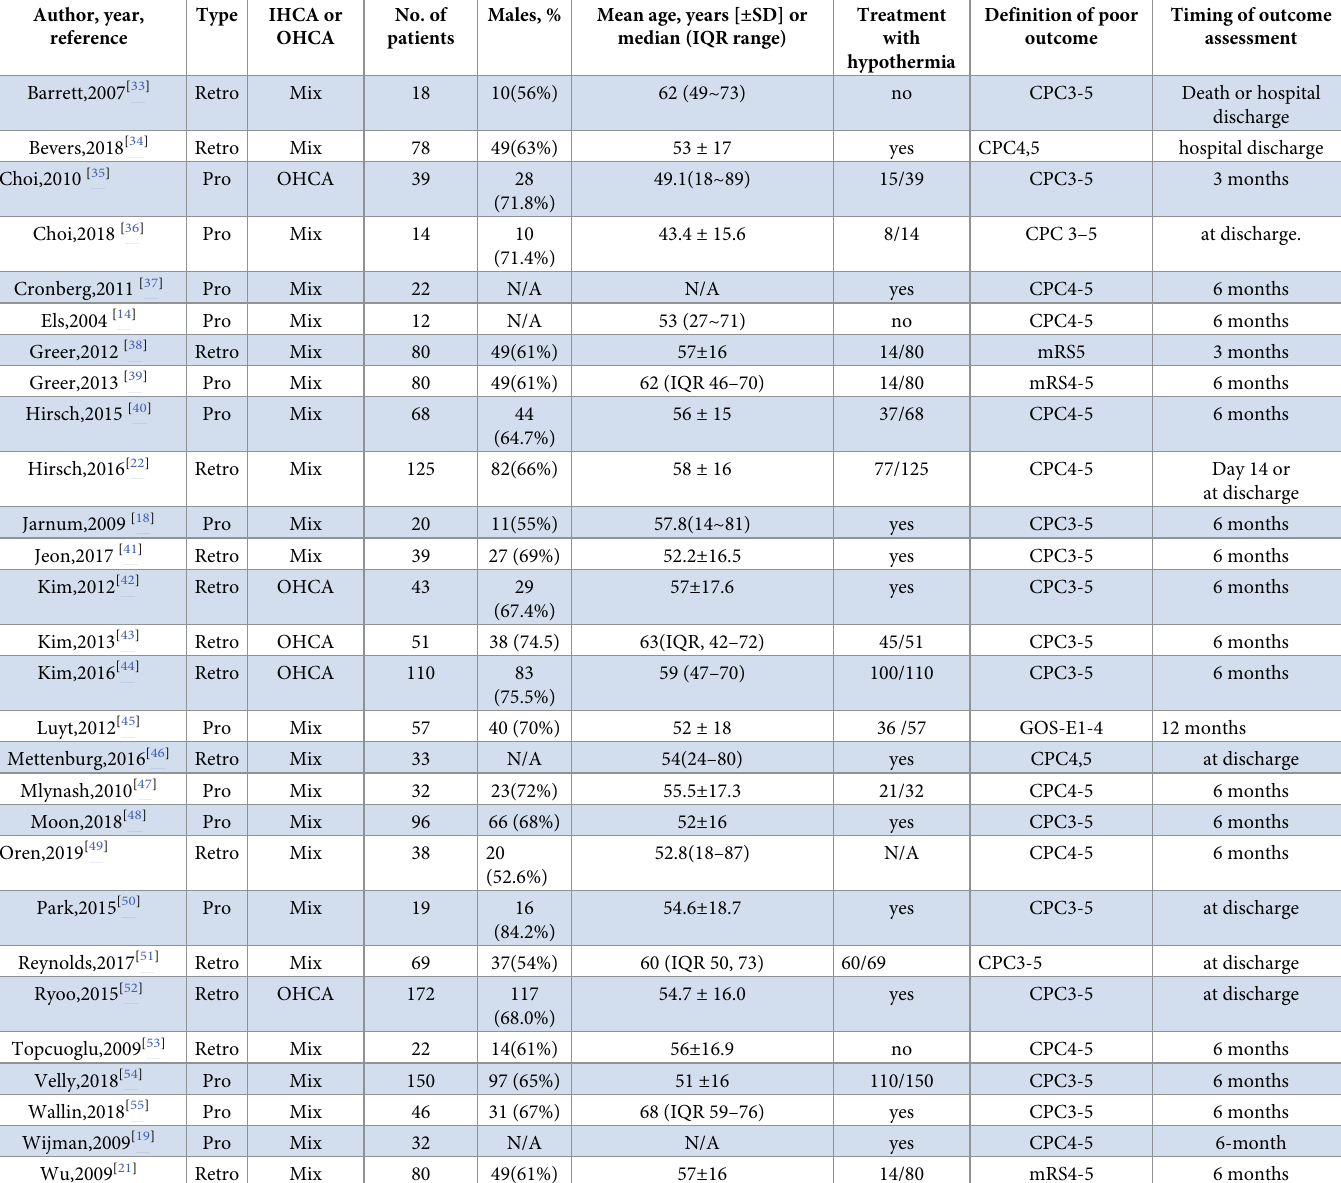
Table 1. Study designs and baseline patient